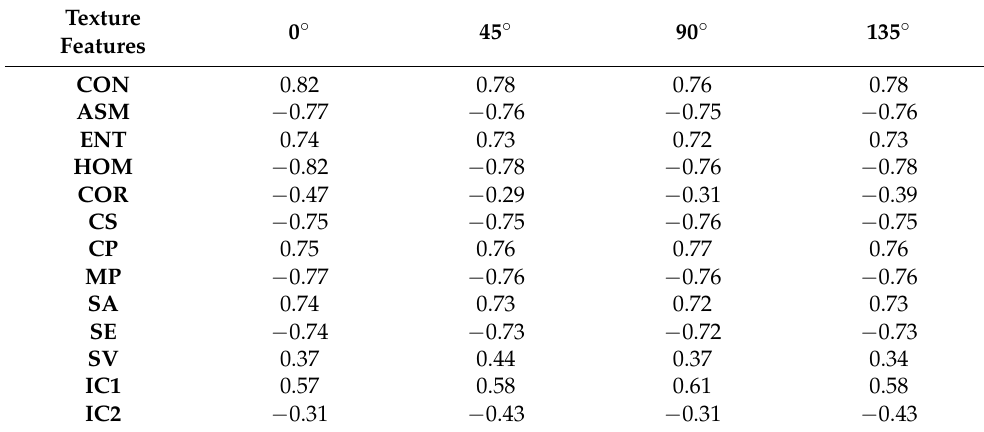
Table 3. Maximum correlation coefficient between texture features and EC in four directions under different gray levels and step